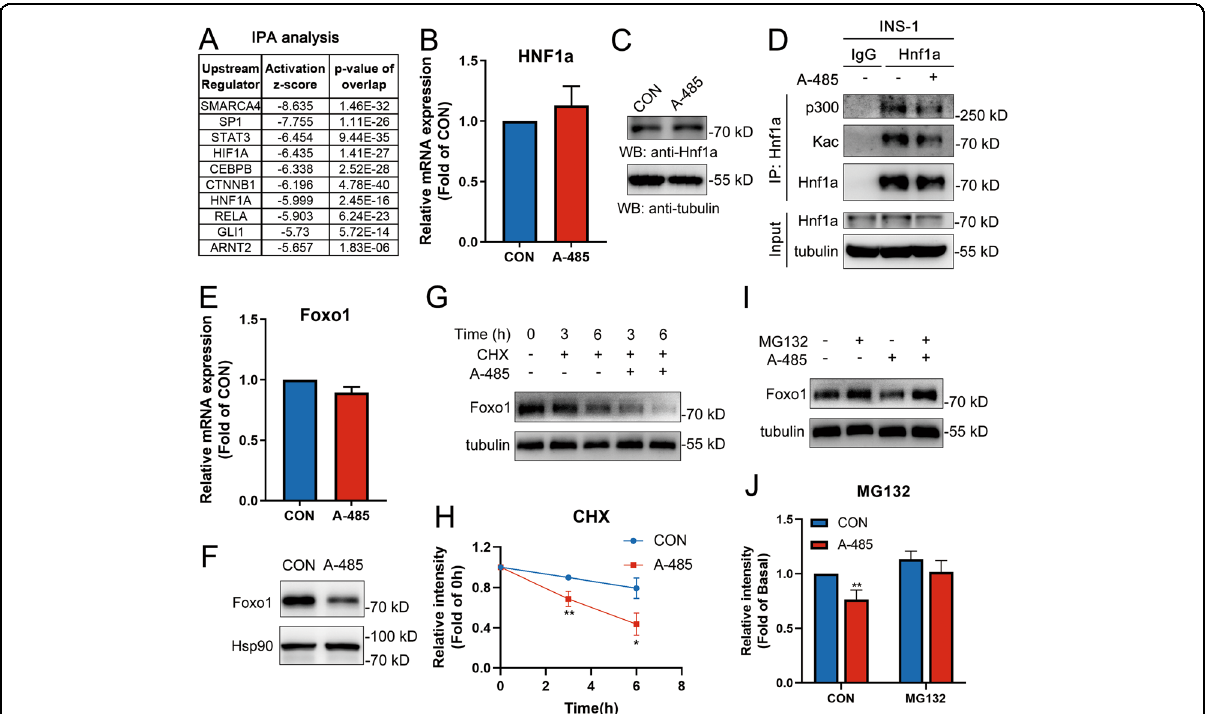
Fig. 6 Transcription factors Hnf1 α and Foxo1 are regulated by CBP/p300 HAT activity. A Top 10 of upstream transcriptional regulators predicted by IPA analysis based on the downregulated gene set identi fi ed in RNA-seq. B – C mRNA and protein levels of Hnf1 α in isolated rat islets treated with A-485 for 16 h. D Co-immunoprecipitation using Hnf1 α antibody in A-485 treated INS-1 cells for 6 h. E – F mRNA and protein levels of Foxo1 in A-485-treated rat islets for 16 h. G – H Foxo1 levels in INS-1 cells treated with 3 μ M A-485 and 10 μ g/ml cycloheximide (CHX) for the indicated time. Signal intensity was quanti fi ed by Image J software for statistical comparison. I – J Foxo1 levels in INS-1 cells treated with 3 μ M A-485 and 10 μ M MG132 for 6 h. Signal intensity was quanti fi ed by Image J software for statistical comparison. Data are given as mean ± SD. * p < 0.05, ** p < 0.01 vs control